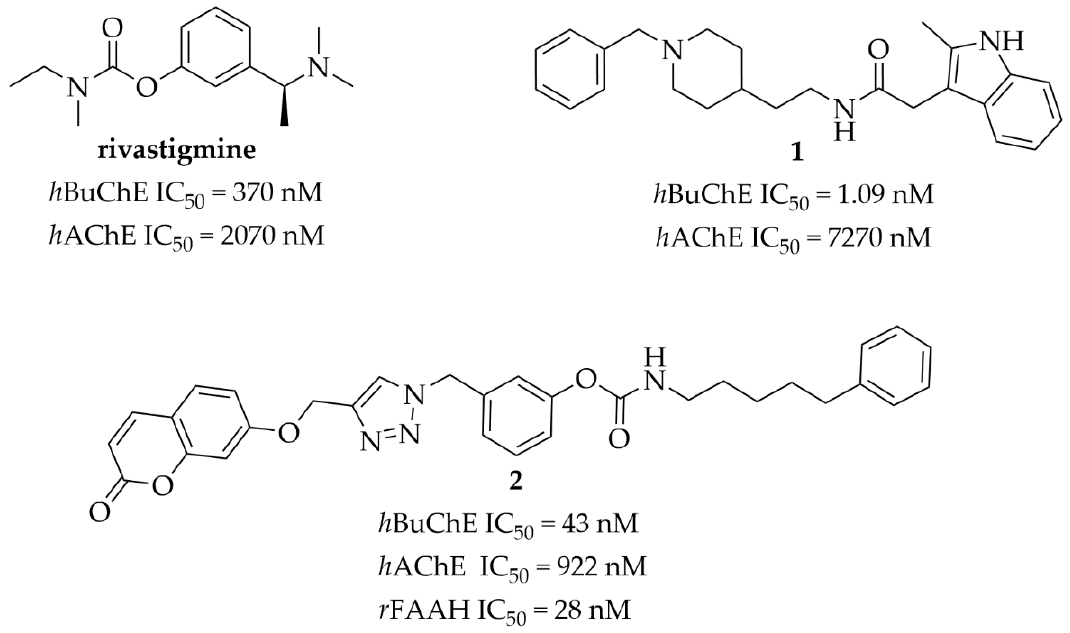
Figure 1. Structures and cholinesterases inhibitory activity of rivastigmine and selected ligands ( 1 and 2 ) [5]. h AChE–human acetylcholinesterase; h BuChE–human butyrylcholineserase; rFAAH–Fatty Acid Amide Hydrolase from rat brain membranes.